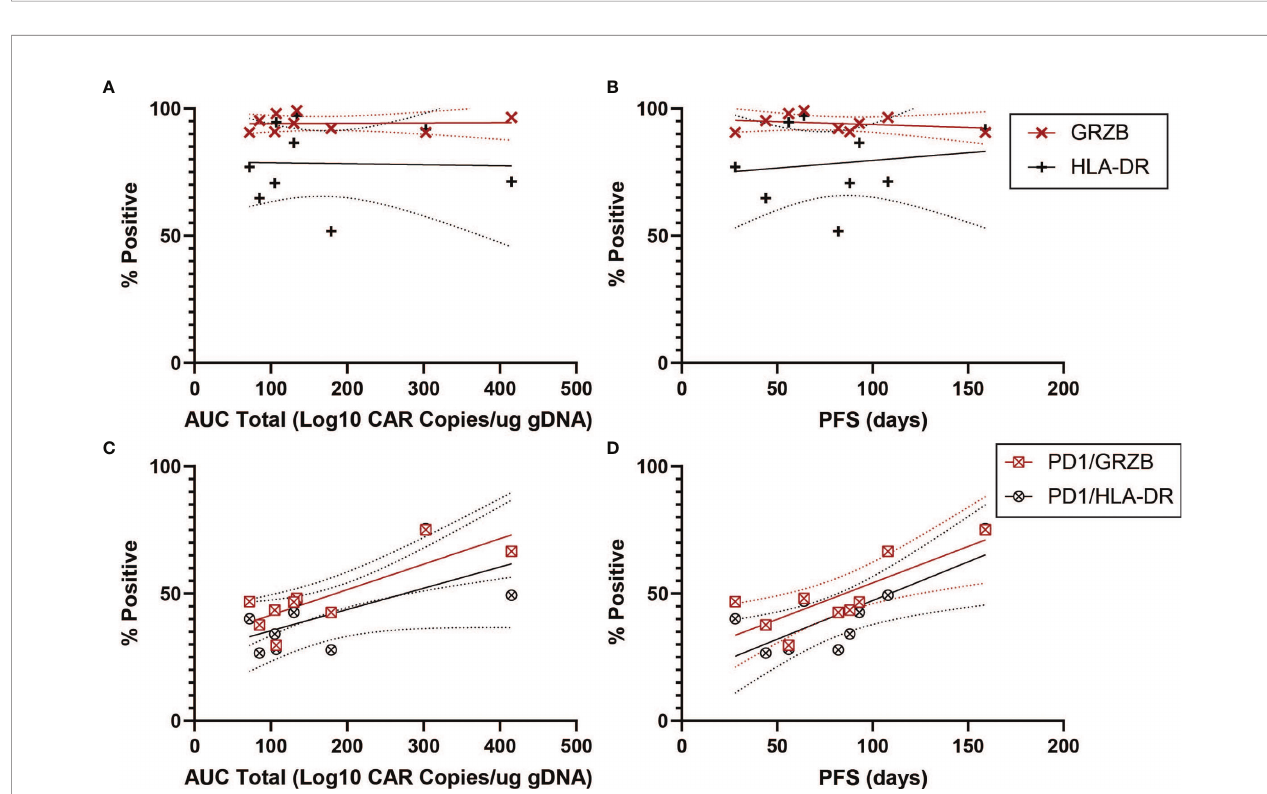
FIGURE 5 | Activation Marker Correlations for CD4 + CAR + Cells in Patient Transduction Products. Correlation of activation marker expression (GRZB, HLA-DR) with clinical outcomes for CD4 + CAR + cells in patient transduction products. (A) Association between activation marker expression and total AUC. (B) Association between activation marker expression and PFS. (C) Correlation of PD1-activation marker co-expression (PD1 + GRZB + and PD1 + HLA-DR + ) and AUC. (D) Correlation of PD1-activation marker co-expression and PFS. Error bars shown are 95% con fi dence